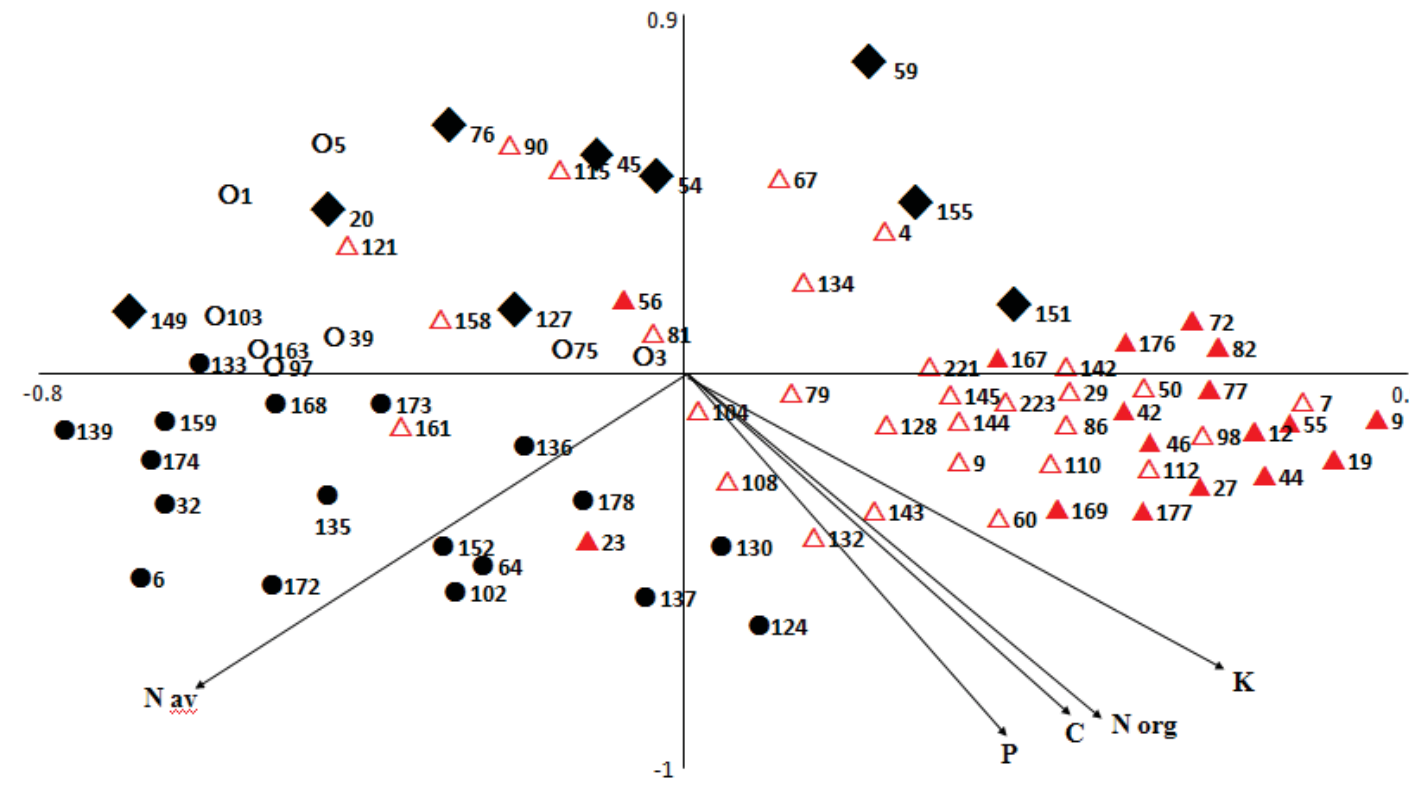
Figure 4. Bi-plot derived from redundancy analysis showing the relationship between protein spots and agronomic factors (categorical , PCM , indicated by black squares; continuous variables, C, P, K, variable, organic and conventional previous soil management, PCM org con organic-N [N ], available N [N ]). Symbols indicate protein spots that had significantly increased abundance ( p < 0.01) when no fertilizer org av (diamonds), low composted cattle manure (transparent red triangles, 85 kg N ha − 1 ), high composted cattle manure (solid red triangle, 170 kg N ha − 1 ), low composted chicken manure pellets (transparent circles, 85 kg N ha − 1 ), or high chicken manure pellets (solid circles, 170 kg N ha − 1 ) was